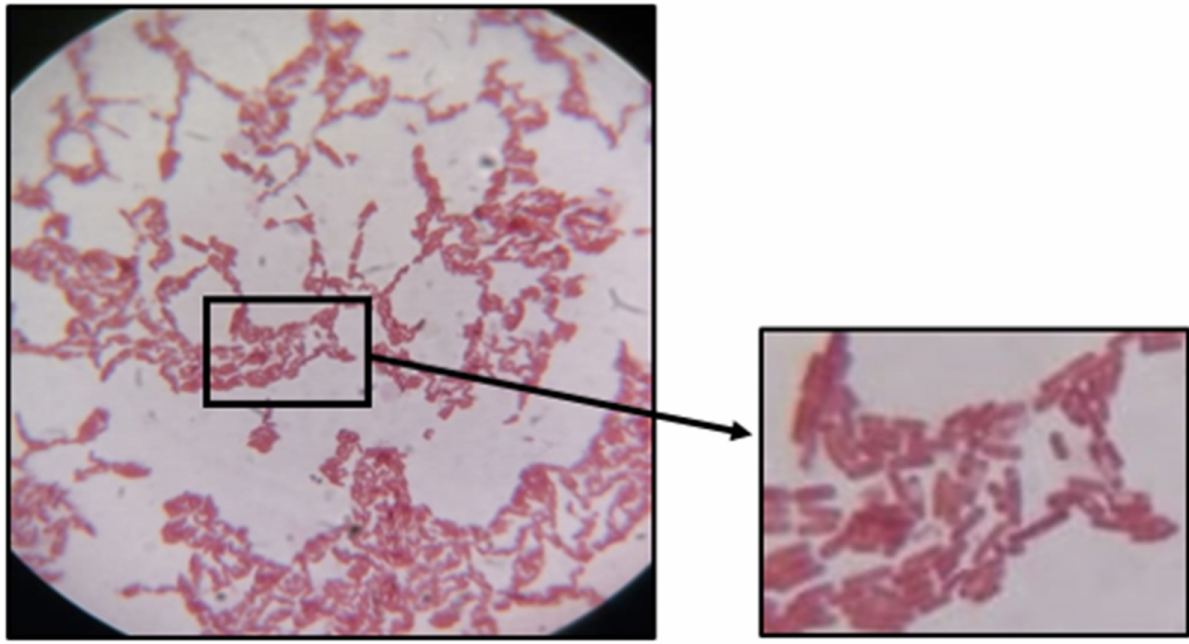
Figure 2. Gram staining